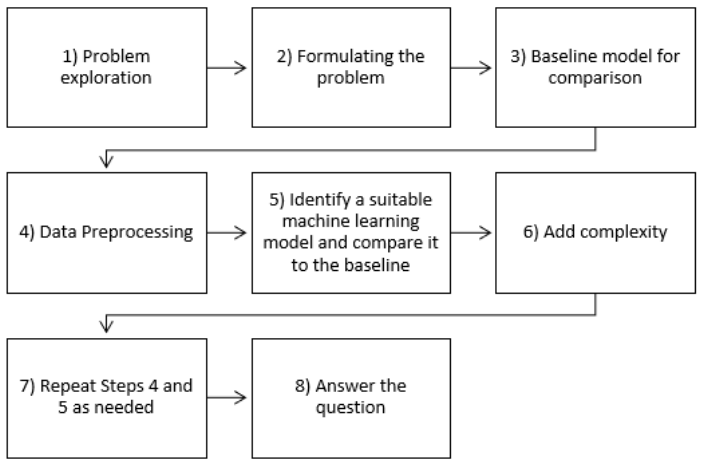
Figure 2. ML modelling workflow.